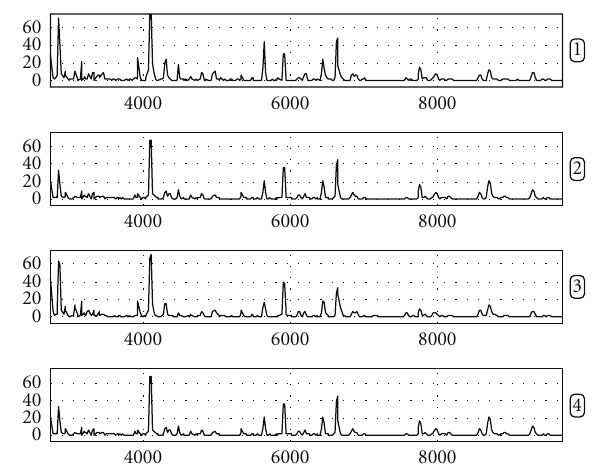
Figure 3: This represented the reproducibility of four separate analyses from the healthy controls of blood type O, suggesting the high reliability of SELDI-TOF MS in serum sample analyses